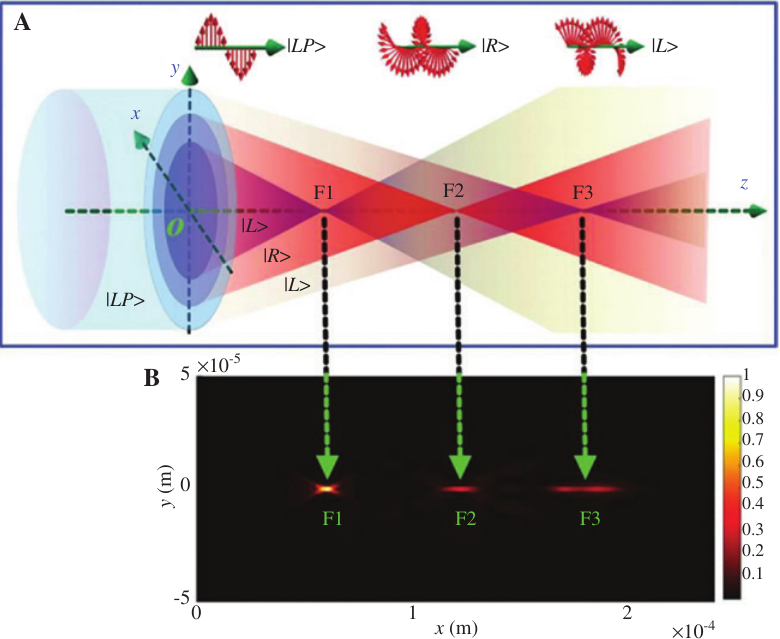
Figure 16: (A) The schematic illustration of the designed longitudinal three-foci metasurface lens; each focal point is the focusing of differ- ent polarization components. (B) The observed light spots correspond to the three focal points. Adapted from Ref. [133].